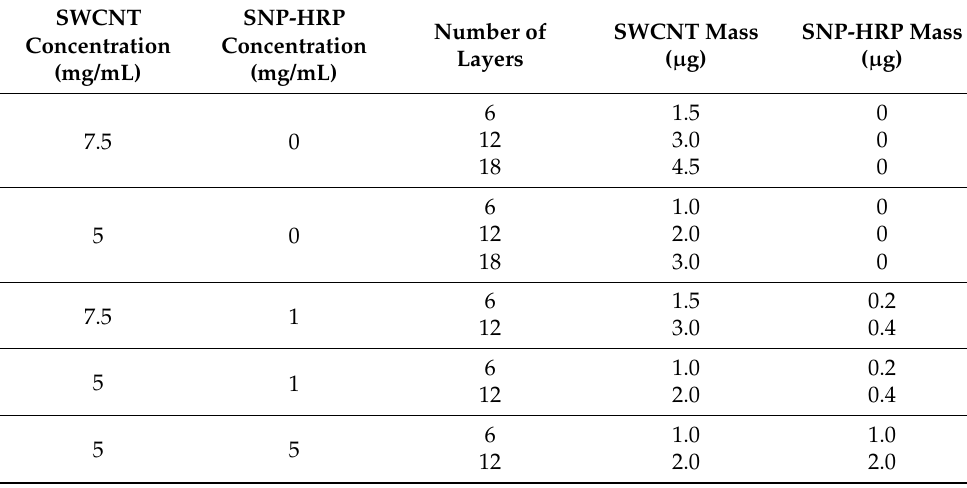
Table 1. Electrodes printed with different combinations of SWCNT and SNP-HRP concentrations and number of layers, including the estimated masses of SWCNT and SNP-HRP deposited on the